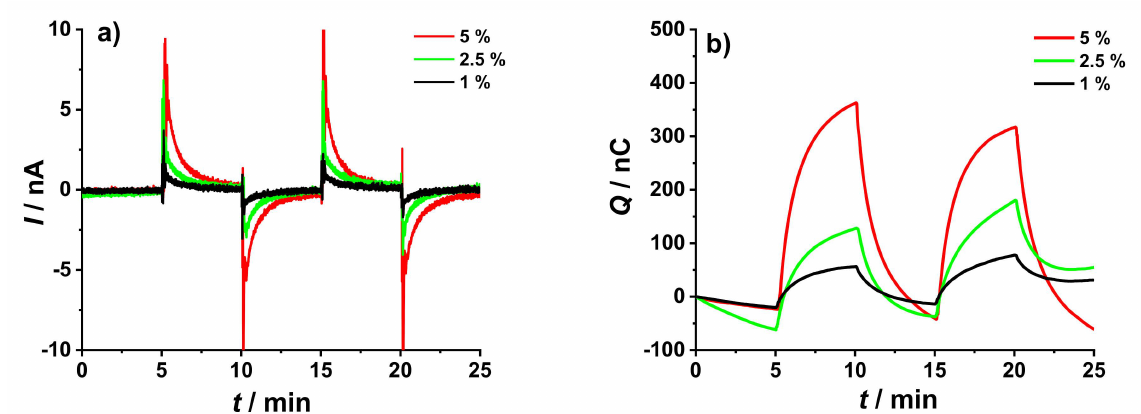
Figure 9. Chronoamperometric ( a ) and chronocoulometric ( b ) response resulted from the addi- tion/dilution experiments using a 3 mm GC/10 mC PEDOT:PSS/25 µ L DM as the WE, GC/2 mC PEDOT:PSS/50 µ L K + - ISM as RE, and GC rod as CE. The addition/dilution steps correspond to 5%, 2.5%, and 1% increase/decrease in K + concentration conducted in a starting solution of 10 − 3 M KCl + 10 − 1 M NaCl as